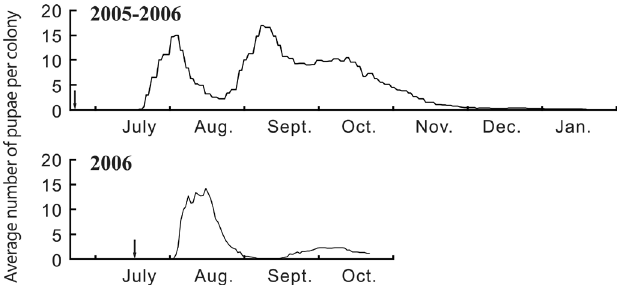
Fig 3 . Mean number of Lasius japonicus pupae under quasi-natural conditions. Arrows indicate the timing of the nuptial flight of queens. N = 21 in 2005 and 17 in 2006.